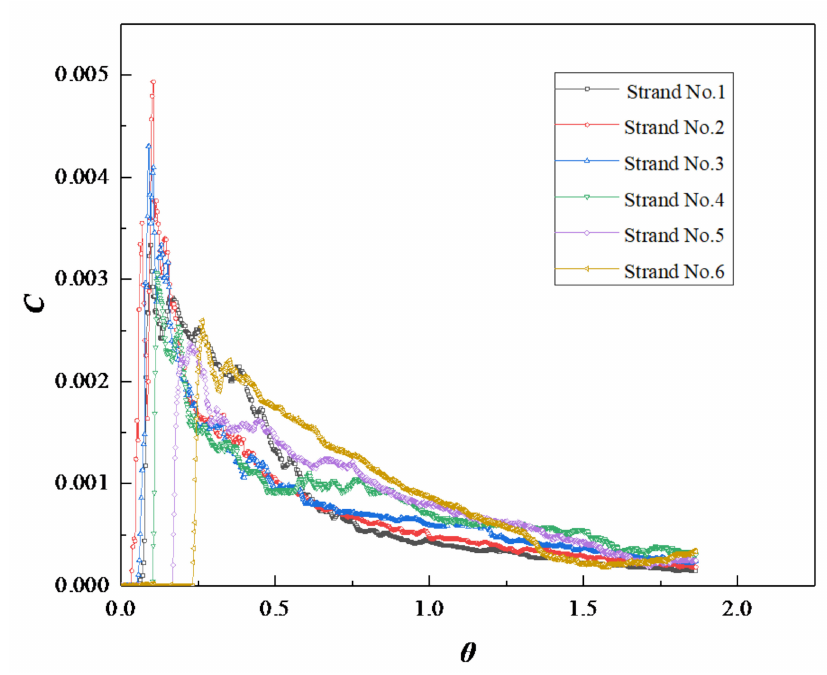
Figure 5. RTD curves of the water modeling